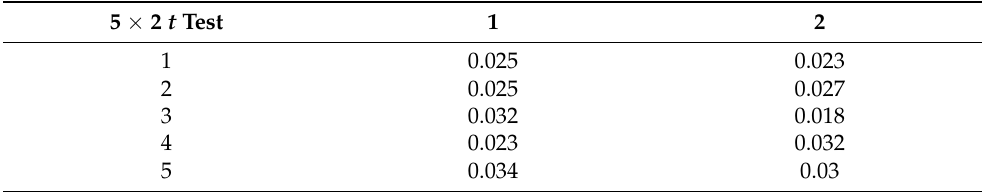
Table 3. Calculated e 2 error values of pump wear condition classification for a simplified model using the 5 most relevant signal